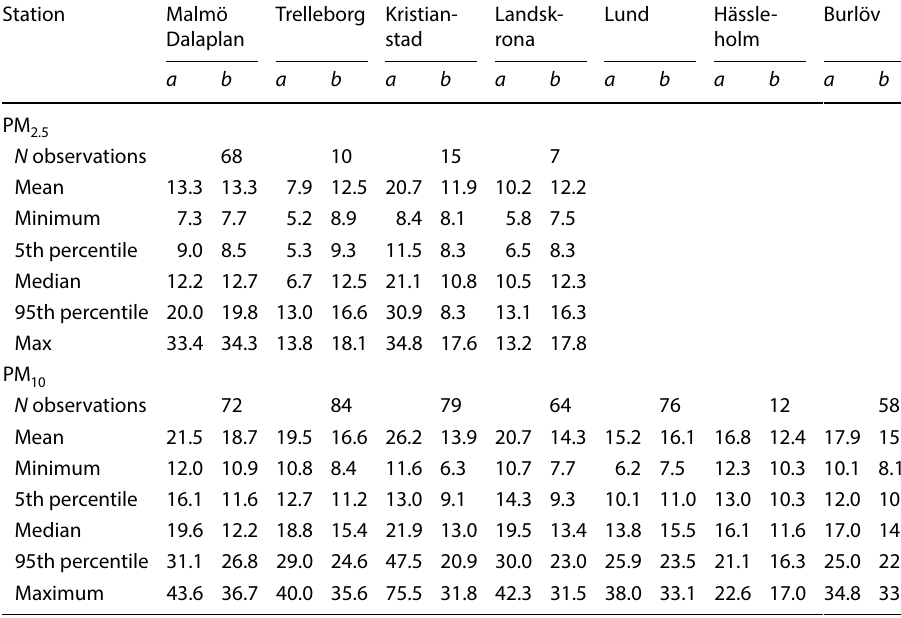
Table 2 Summary of measured (a) and modelled (b) total concentrations of particulate matter (PM) as monthly averages in µg/m 3